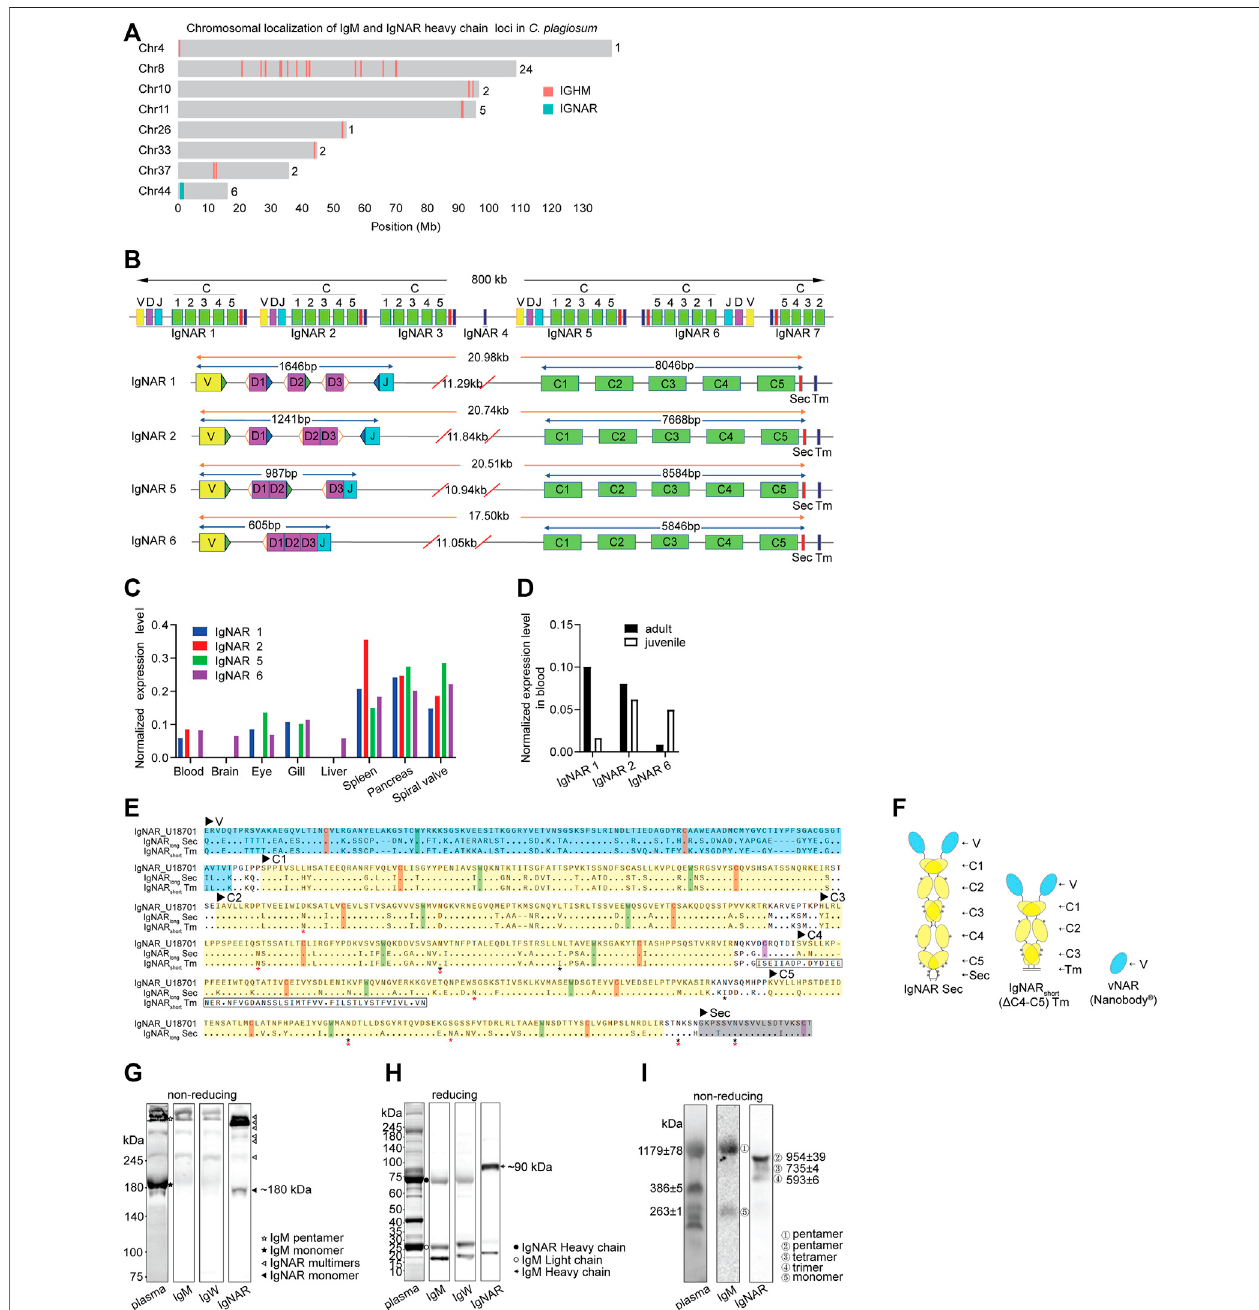
FIGURE1| CharacterizationofIgNARinbamboo sharks. (A) ChromosomallocalizationsofIgMlociand IgNARloci.Numbersbehindthechromosomesrepresent thenumbers oflociintherespectivechromosome. (B) Germlinecon fi gurations ofsevenIgNARclusters.Thepositionand orientation ofrecombination signalsequences (RSS) are present beside the Variable (V), Diversity (D), and Joining (J) gene segments, whereas hollow triangles represent 12-bp spacer RSS, blue solid triangles represent 23-bp spacer RSS, and green solid triangles represent 22-bp spacer RSS. “ C, ” constant domains; “ Sec, ” secretory tail; and “ Tm, ” transmembrane tail. (C,D) ExpressionlevelofIgNARmRNAindifferenttissues (C) andage (D) revealedbymulti-tissuetranscriptome. (E) ProteinsequencealignmentoftwoIgNARisoforms from bamboo shark with Ginglymostoma cirratum (Gc) IgNAR (Genbank U18701). Variable (V, blue shading) and constant (C, yellow shading) domains, and Sec (grey shading)andTm(boxed)tailsareindicated.Conservedcysteinesforintradomaindisul fi debonds(red)andforinter-domaindisul fi debonds(purple)andtryptophan(blue) are highlighted. Asterisks indicate potentialN-linked glycosylation sites (Red for IgNAR long Sec and IgNAR short Tm, and Black for U18701). (F) Schematic representation of IgNAR long Sec, IgNAR short Tm and vNAR. (G, H) Three Ig isotypes (IgM, IgW, and IgNAR) in plasma were analyzed by non-reducing (G) and reducing (H) SDS-PAGE and WB.The blocked membraneswereprobed with rabbit anti-IgNAR pAb,anti-IgW oranti-IgM,followed bysecondary antibodyHRPconjugate beforedetection.IgM monomer, 200 – 220 kDa; IgM pentamer, 1,000 – 1,200 kDa; IgNAR monomer, 180 – 200 kDa; IgM heavy chain, ∼ 75 kDa; IgM light chain, ∼ 25 kDa; and IgNAR heavy chain, ∼ 90 kDa. (I) SeparationofIgMmultimersand IgNARmultimers.Circlednumbersindicate ① -IgMpentamer (1179 ± 78 kDa), ② -IgNAR pentamer (954 ± 39 kDa), ③ -IgNAR tetramer (735 ± 4 kDa), ④ -IgNAR trimer (593 ± 6 kDa), and ⑤ -IgM monomer (263 ± 1 kDa).